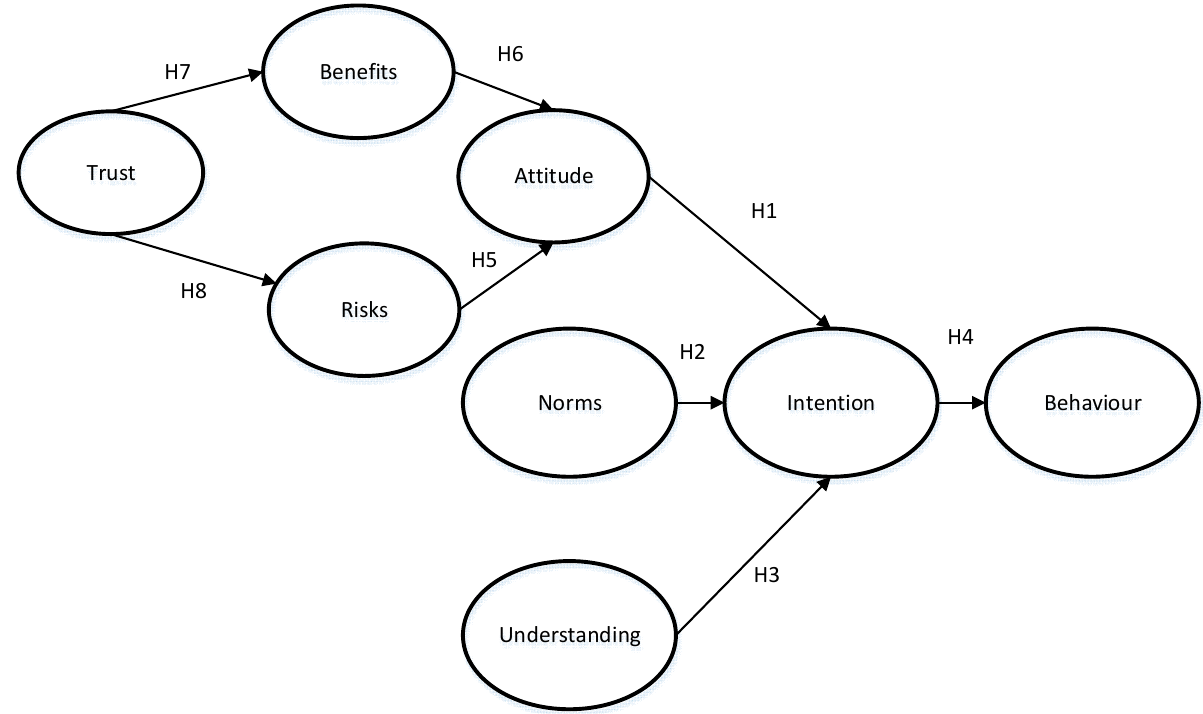
Figure 1. Research model.